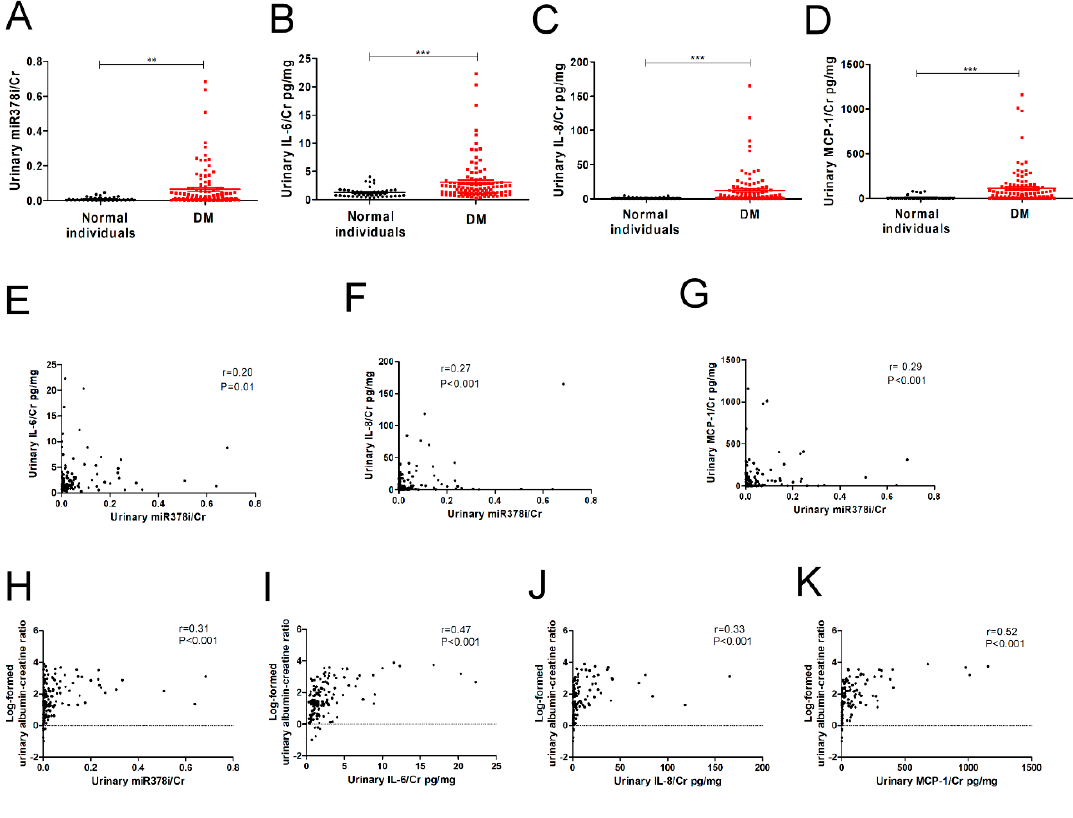
Figure 6. Urinary miR-378i is positively correlated with SASP and renal dysfunction in type 2 DM patients. ( A ) Urinary miR-378i levels were higher in type 2 DM patients ( n = 107) compared to healthy individuals ( n = 45). Urinary SASP levels, including interleukin-6 (IL-6) ( B ), IL-8 ( C ), and monocyte chemoattractant protein-1 (MCP-1) ( D ), were higher in type 2 DM patients than in healthy individuals. Urinary miR-378i levels were positively correlated with SASP, including IL-6 ( E ), IL-8 ( F ), and MCP-1 ( G ), in the urine of humans. Urinary miR-378i levels ( H ), IL-6 ( I ), IL-8 ( J ), and MCP-1 ( K ) were positively correlated with log-formed urinary albumin/creatinine ratio (ACR) in human participants. Human participants with macroalbuminuria had higher urinary miR-378i levels ( L ), IL- 6 ( M ), IL-8 ( N ), and MCP-1 ( O ), than those with normoalbuminuria. Urinary miR-378i levels ( P ), IL-